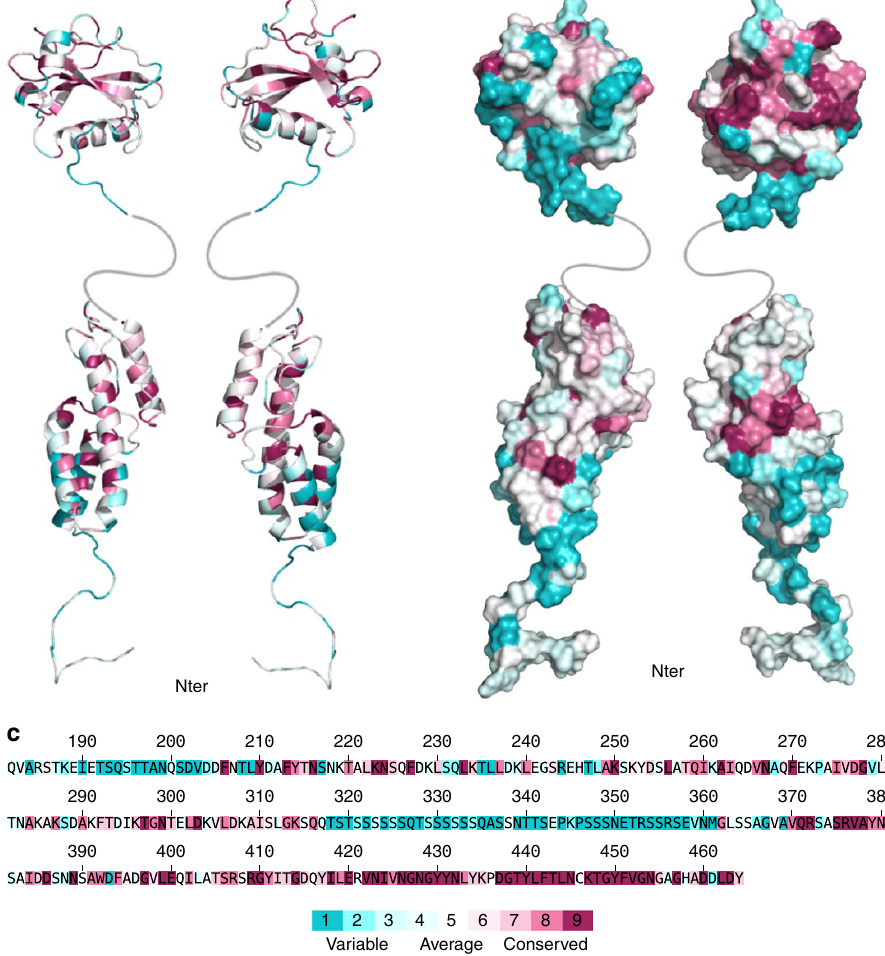
Figure 3 | Amino-acid conservation in MapZ extra . Sequence conservation scores ( a ) inside or ( b ) at the surface of MapZ extra NMR structures was calculated by the Consurf webserver 50 . Scores range from 1 (not conserved, cyan) to 9 (highly conserved, magenta). In a and b , left and right structures are rotated by 180 (cid:2) along the y axis. These scores are also displayed on the MapZ extra sequence ( c ), with the Consurf colour code reported